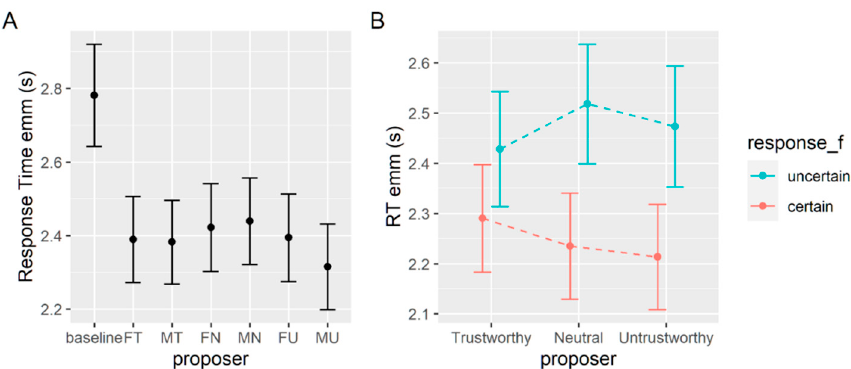
Figure 6. ( A ) Estimated marginal means of response times in seconds for the baseline and each experimental condition in the probabilistic discounting task. ( B ) Estimated marginal means of response times for each level of trustworthiness when the preference was for the certain (red) or uncertain (blue) options. Table 8. Results of Wald χ ² test for the glmm on response times. df = degree of freedom. Signifi- cant p values are reported in bold.